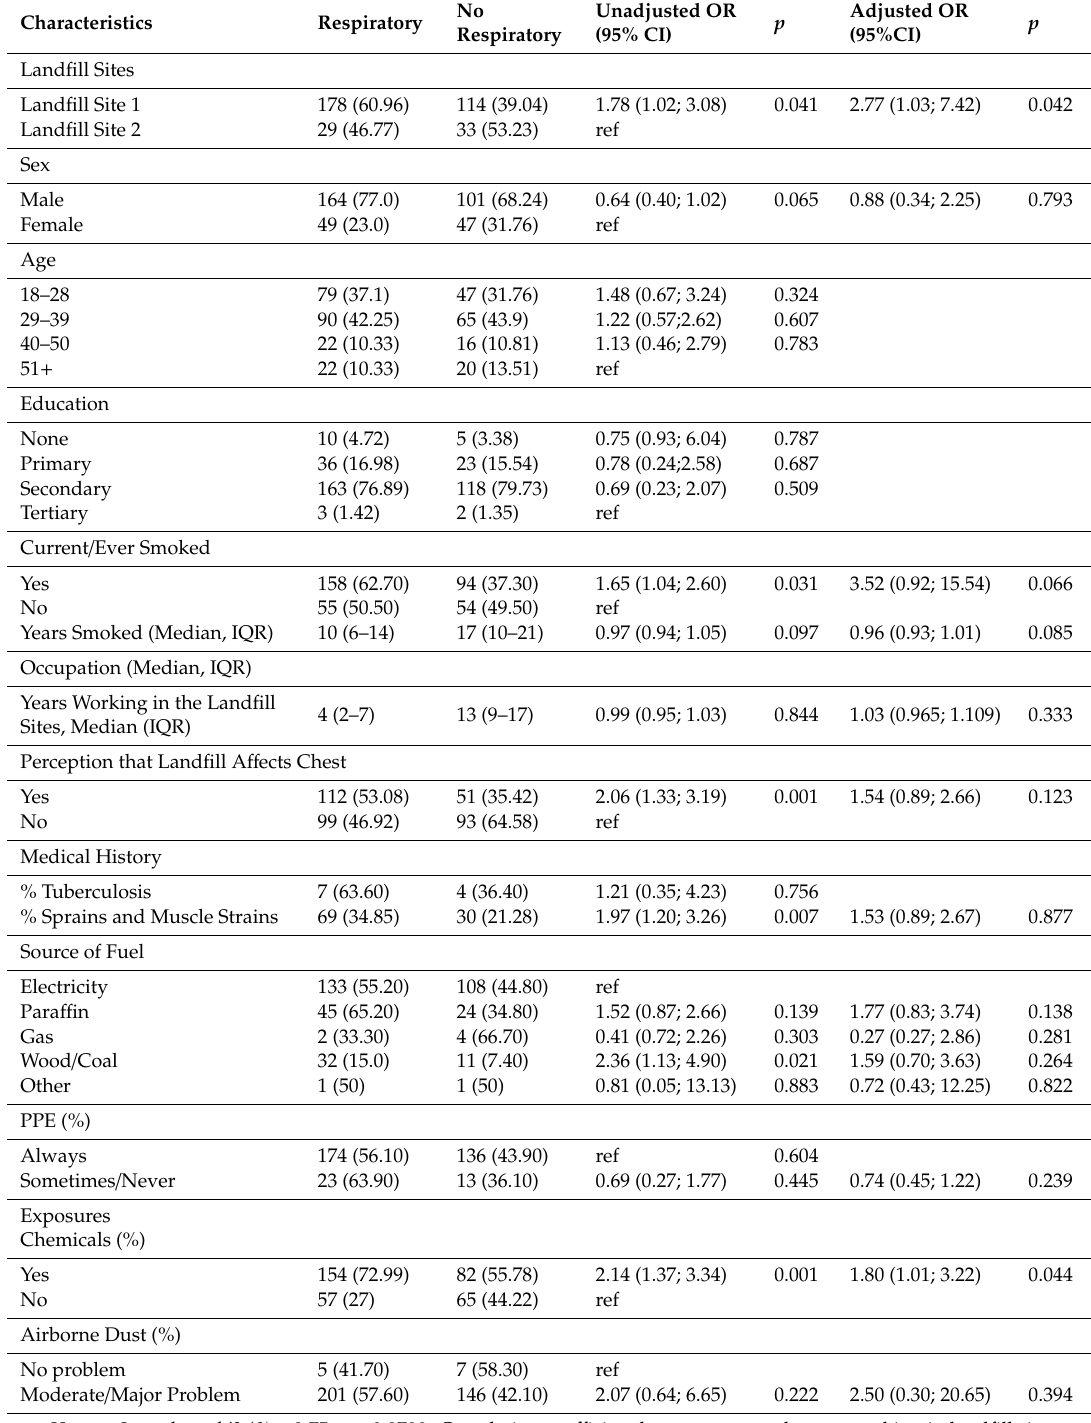
Table 4. Crude and adjusted odds ratios from univariable and multivariable analysis of study variables and respiratory